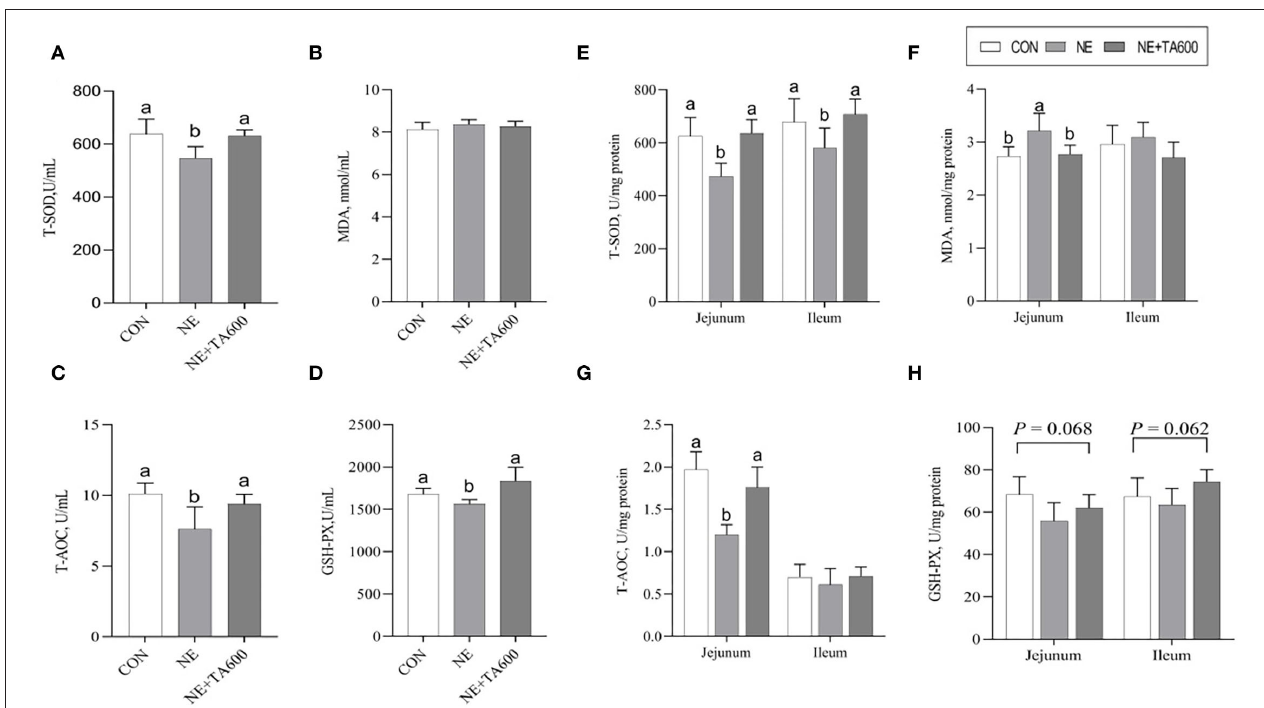
FIGURE 2 | Effects of TA on the activities of antioxidant enzymes in the serum and intestine of subclinical NE broilers. (A–D) The activities of T-SOD, MDA, T-AOC, and GSH-PX of serum; (E–H) The activities of T-SOD, MDA, T-AOC, and GSH-PX in the jejunum and ileum. Values are means with their standard errors represented by vertical bars. a,b Means within a row with different letters differ significantly ( p < 0.05). T-SOD, total superoxide dismutase; MDA, malondialdehyde; T-AOC, total antioxidant capacity; GSH-PX, glutathione